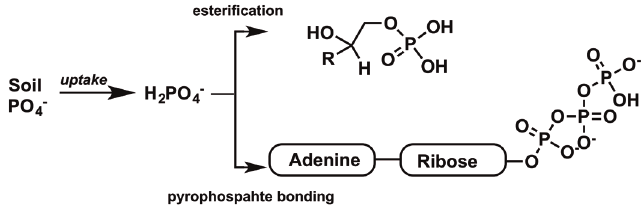
Figure 52 - Phosphorus uptake and its metabolic